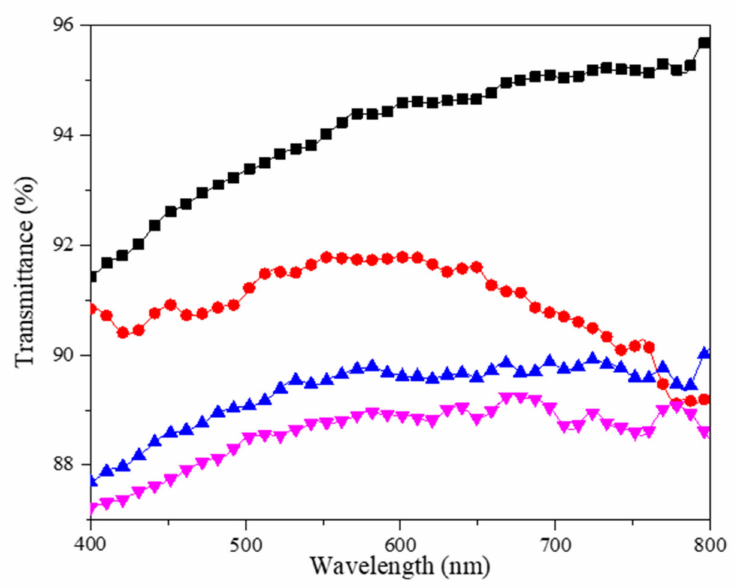
Figure 8. Transformation in transmittance of P-R film. Before spray simulation (- (cid:4) -); spray simulation for 2 min (- • -); for 4 min (- (cid:78) -); for 6 min (- (cid:72) -).